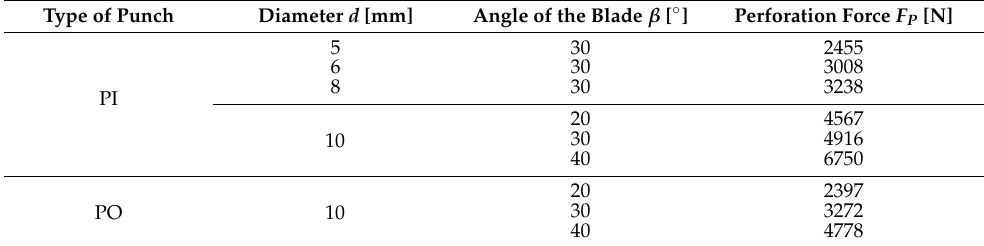
Table 3. Summary of the experimental results for TFL10S belt.